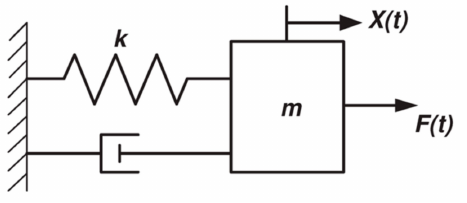
Figure 9. Spring mass damper lumped model equivalent of the comb drive